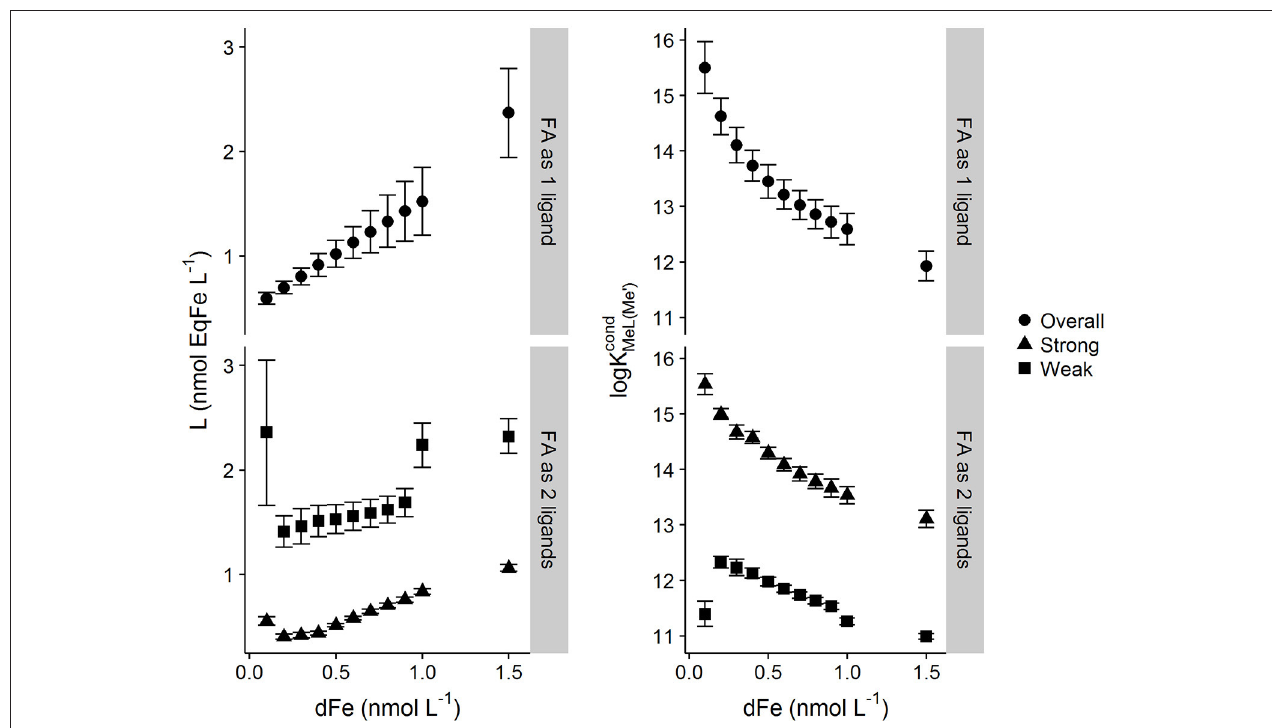
FIGURE 3 | Ligand and conditional stability quotients obtained from simulated multiwindow titrations of a heterogeneous mix of binding sites described by the NICA model of fulvic acid (DOC = 64 µ mol L − 1 ) with different starting dissolved iron concentrations (0.05–1.5 nmol kg − 1 ). [ L i ] and log K cond MeL unified Sander–Wells method within the computer program ProMCC. Titrations were interpreted as one overall ligand and as two ligands (“weak” and “strong”). Error bars represent 95% confidence